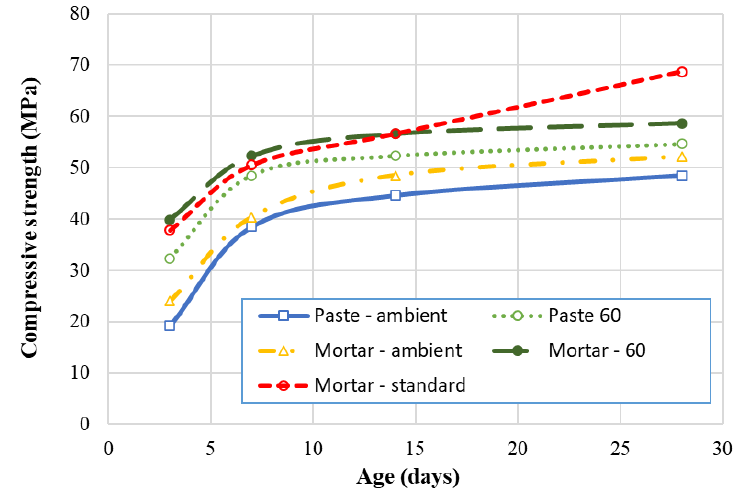
Figure 17. Compressive strength of geopolymer pastes/mortars.